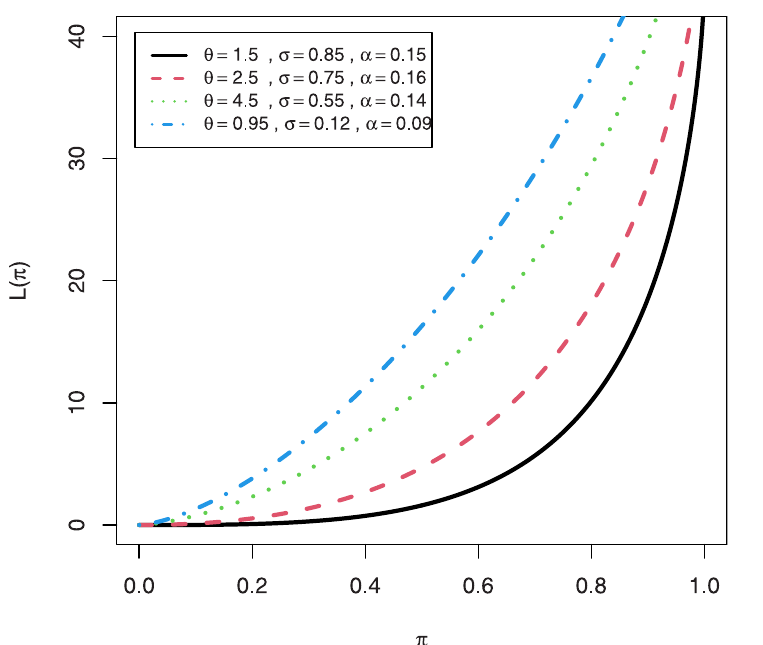
Fig 13. Plots of the Lorenz curves of EGuNH distribution.